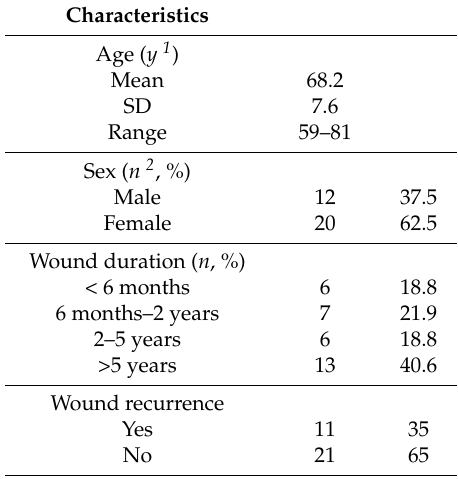
Table 1. Overview of participants’ characteristics and wound duration.